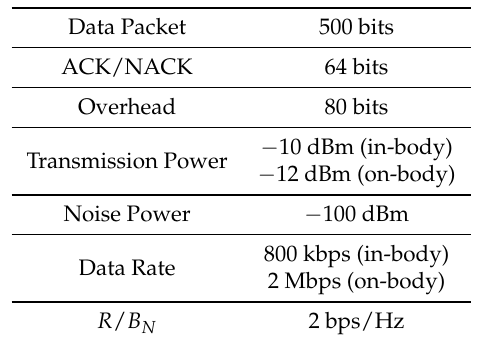
Table 2. Simulation